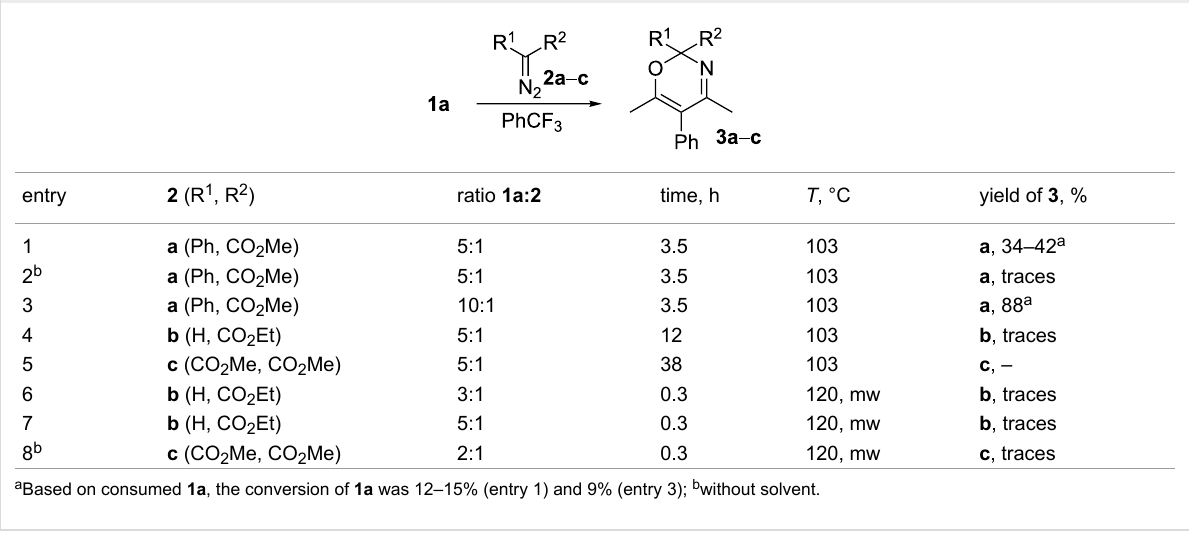
Table 1: Reaction of azirines 1a with diazo compounds 2a–c without a catalyst.